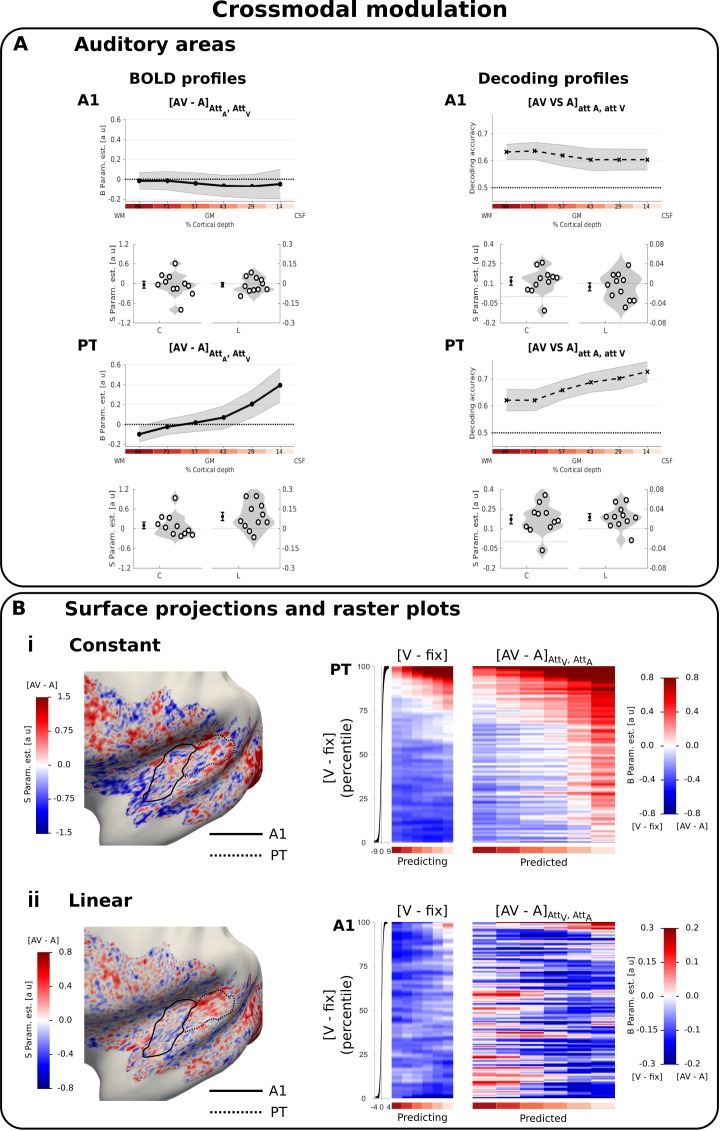
Cross-modal modulation in auditory areas.(A) Laminar profiles: Rows 1 and 3: The BOLD response (solid line; column 1 and 3) and decoding accuracy (dashed line; columns 2 and 4) (across subjects’ mean ± SEM) for [AV-A] in A1 and PT is shown as a function of percentage cortical depth pooled (i.e. averaged) over auditory and visual attention. WM: white matter, GM: grey matter, CSF: cerebrospinal fluid. Percentage cortical depth is indicated by the small numbers and colour coded in red. Rows 2 and 4: Across subjects’ mean (± SEM) and violin plot of participants’ shape parameter estimates that characterize the mean (C: constant) and linear increase (L: linear) of the laminar BOLD response and decoding accuracy profiles. n = 11. (B) Surface projections and raster plots: Left: Across subject’ mean of the ‘constant’ (row i) and ‘linear increase’ (row ii) shape parameter estimates of the laminar BOLD response profile for [AV-A] (averaged over auditory and visual attention) are projected on an inflated group mean surface to show auditory regions of the left hemisphere. A1 and PT are delineated by black solid and dashed lines. For visualization purposes only: i. surface projections were smoothed (FWHM = 1.5 mm); ii. values are also presented for vertices for which data were not available from all subjects and which were therefore not included in our formal statistical analysis. Grey areas denote vertices with no available data for any subject. Right: Row i. PT: The raster plot illustrates the statistical relationship between the ‘constant’ shape parameters for the visual evoked response [V-Fix]AttA, AttV and the crossmodal modulation [AV-A]AttA, AttV in PT. Each raster plot shows the laminar profiles (colour coded along abscissa) of the vertices for the ‘predicting contrast’ [V-Fix] and of the ‘predicted contrast’ [AV-A]. The laminar profiles of the vertices were sorted along the ordinate according to the value of the ‘constant’ shape parameter for [V-Fix]. The raster plot shows that the laminar profile of a vertex for [V-Fix] can predict its laminar profile for [AV-A]: PT vertices with less deactivations across laminae for [V-Fix] are associated with greater crossmodal enhancement [AV-A]. Row ii. The raster plot illustrates the statistical relationship between the ‘linear slope’ shape parameters for the visual evoked response [V-Fix]AttA, AttV and the crossmodal modulation [AV-A] in A1. Each raster plot shows the laminar profiles (colour coded along abscissa) of the vertices for the ‘predicting contrast’ [V-Fix] and of the ‘predicted contrast’ [AV-A]. The laminar profiles of the vertices are sorted along the ordinate according to the value of the ‘linear’ shape parameter for [V-Fix]. A1 vertices with less deactivations in deeper laminae for [V-Fix] are associated with greater crossmodal enhancement [AV-A] in deeper laminae. To enable averaging the raster plots across participants, the vertices were binned after sorting (number of bins for A1: 10100, number of bins for PT: 6800). For visualization purposes all raster plots were smoothed along the vertical axis (FWHM = 1% of the number of data bins). The subplot (i.e. black line) to the left of the raster plots shows the across subjects’ mean value (+ /- STD) of the shape parameters (i.e. i. constant, ii, linear) of the sorting contrast. n = 11.